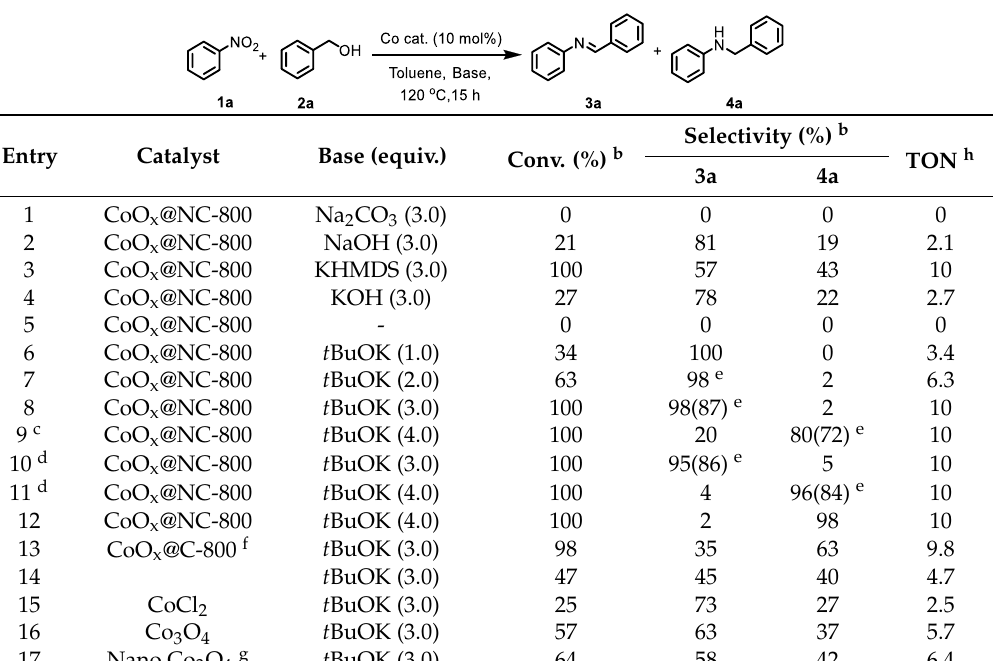
Table 1. Optimization of the reaction conditions a .